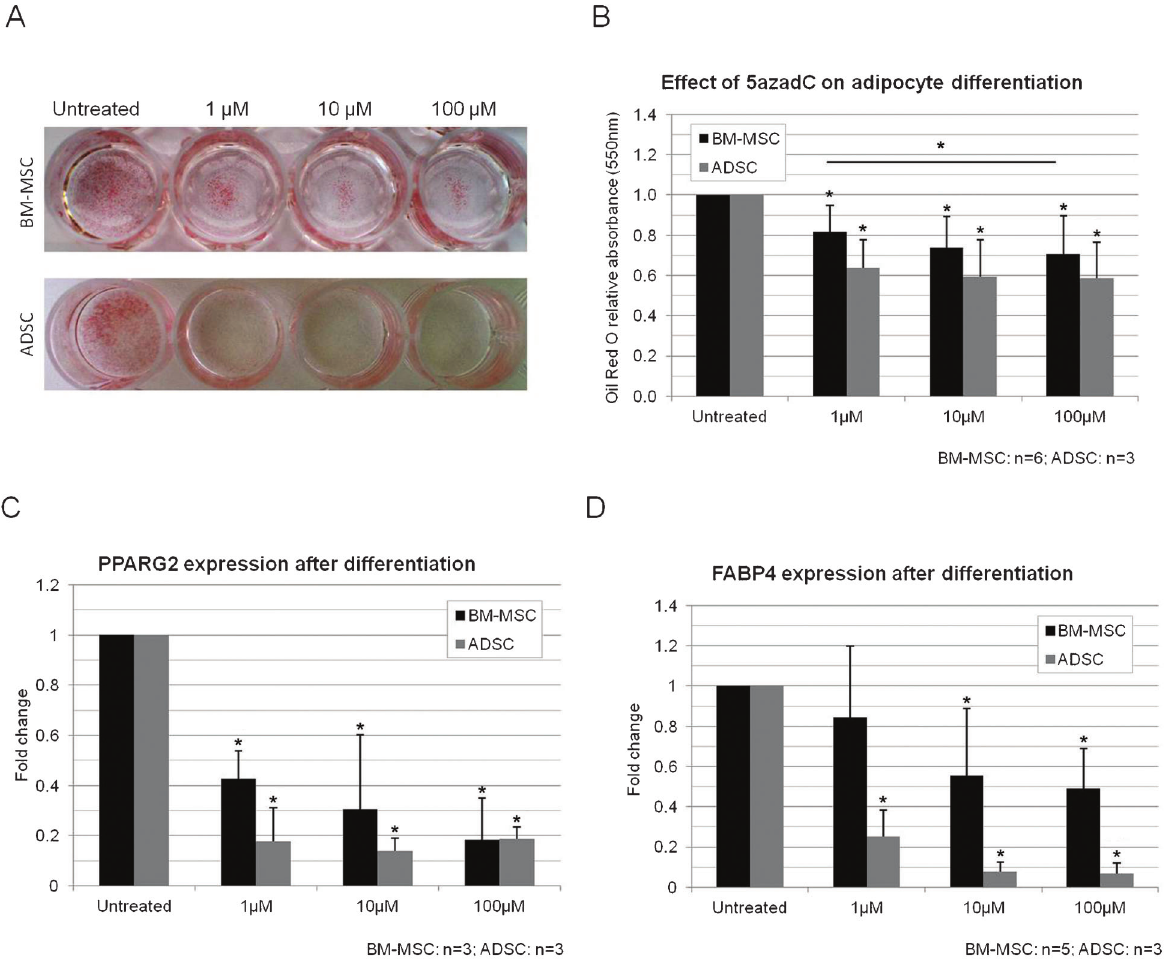
Figure 7. Effect of treatment with 5azadC (1, 10 and 100 m m) on differentiation of MSCs. A , Effect of 5azadC on the adipogenic differentiation of BM-MSC and ADSC cultures observed after staining with Oil Red O. B , Relative quantification of adipocyte differentiation. C , PPARG and D , FABP4 expression in the cultures after 14 days of adipocyte differentiation. 5azadC = 5-aza-2 9 - deoxycytidine; MSCs = mesenchymal stem cells; BM-MSCs = bone marrow MSCs; ADSCs = adipose tissue stem cells. Data are reported as means ± SD. Asterisks just above SD bars indicate statistically significant differences with respect to untreated cultures of BM-MSCs or ADSCs. *P , 0.05 (Student t